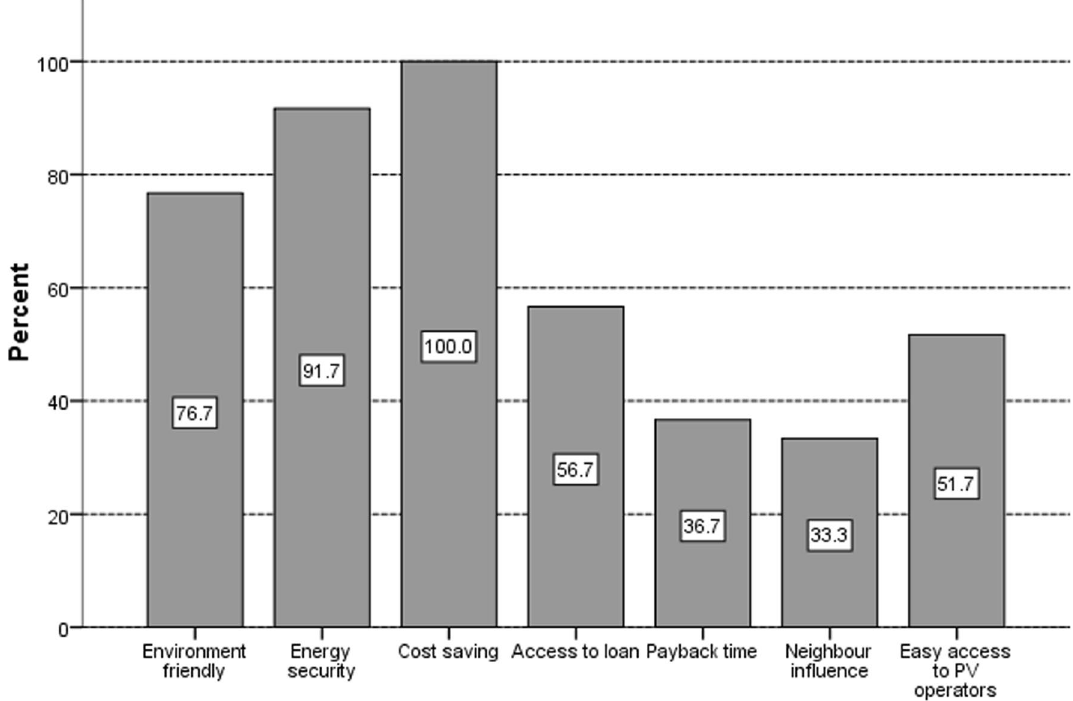
Fig. 1 Motivations for PV uptake among the 60 surveyed householders that had adopted PV. Note: multiple response question (% >